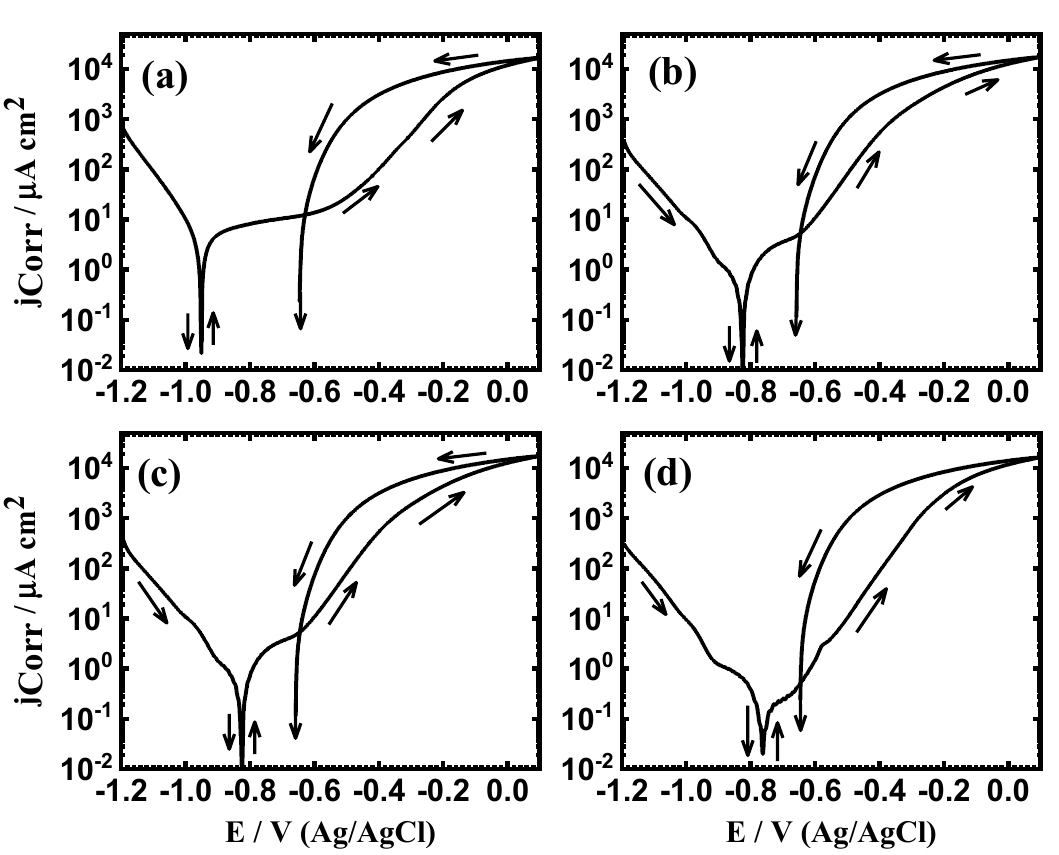
Figure 2. Potentiodynamic cyclic polarization (PCP) curves for iron rod after 1 h immersion in ( a ) 3.5% NaCl without and with ( b ) 5 × 10 − 5 M MAO, ( c ) 1 × 10 − 4 M MAO, and ( d ) 5 × 10 − 5 M MAO present, respectively.